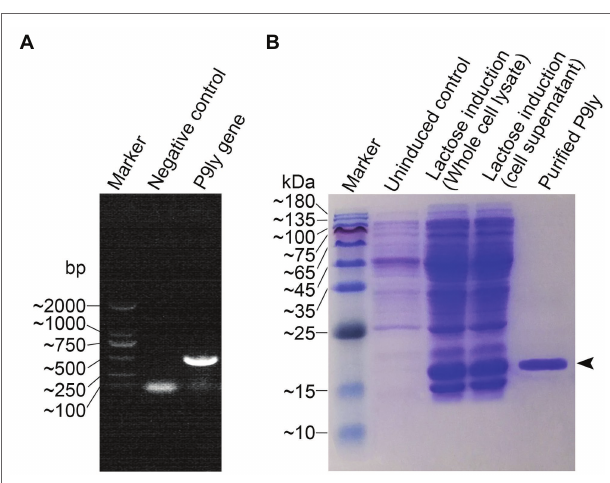
FIGURE 3 | Gene cloning, recombinant protein expression, and purification of the lytic enzyme P9ly. (A) The bacteriophage PSD9 genome was used as a template for PCR amplification of the P9ly gene. (B) A final concentration of 1 g/L lactose was used to induce overexpression of recombinant P9ly, and the final purified recombinant lytic enzyme P9ly was analyzed using 15% SDS-PAGE. Black arrows indicate the protein band of the recombinant